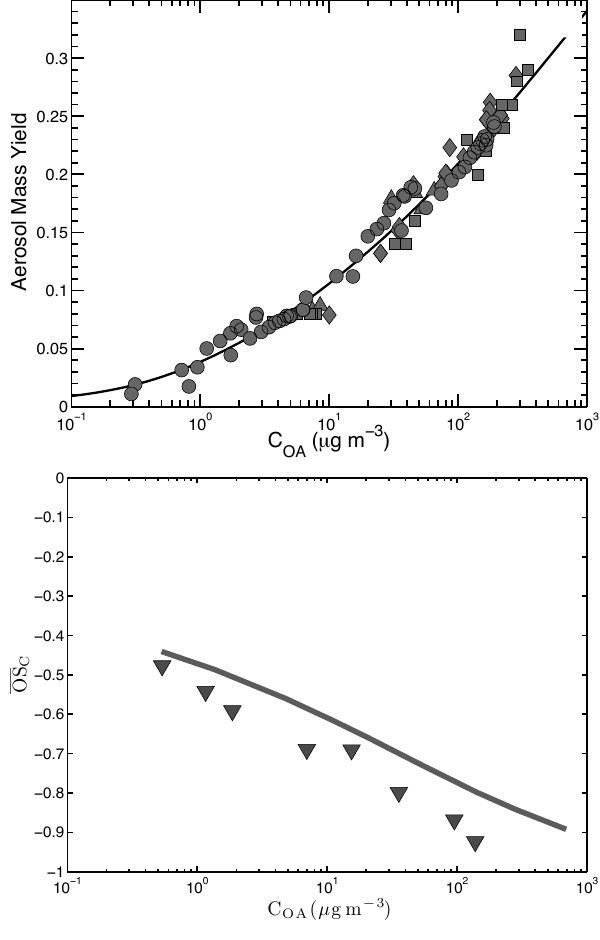
Fig. 2. (a) SOA mass yields (Presto and Donahue, 2006)) and (b) average oxidation state of carbon (OS C ) (Shilling et al., 2009)) from α -pinene+O 3 , both plotted vs. SOA mass (C OA ). SOA mass yields are used to fit the 1-D-VBS product distribution and OS C constrains the product oxidation state. Partitioning predictions are shown as